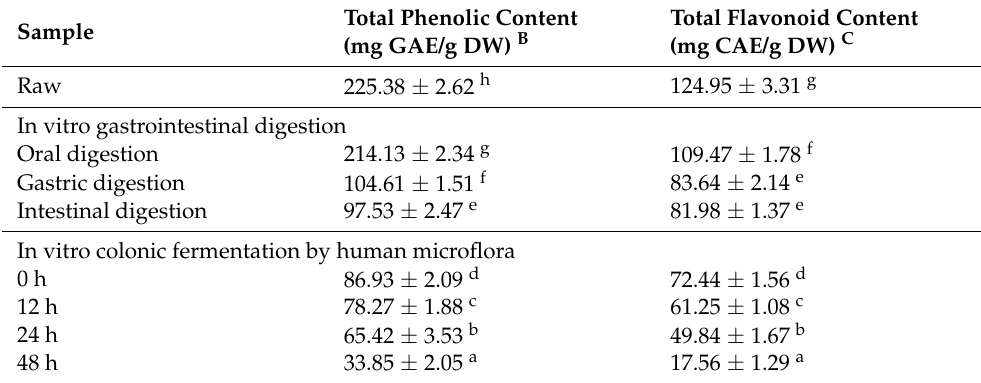
Table 1. Total phenolic content and total flavonoid content of THR extract during in vitro gastroin- testinal digestion and colonic fermentation by human microflora A